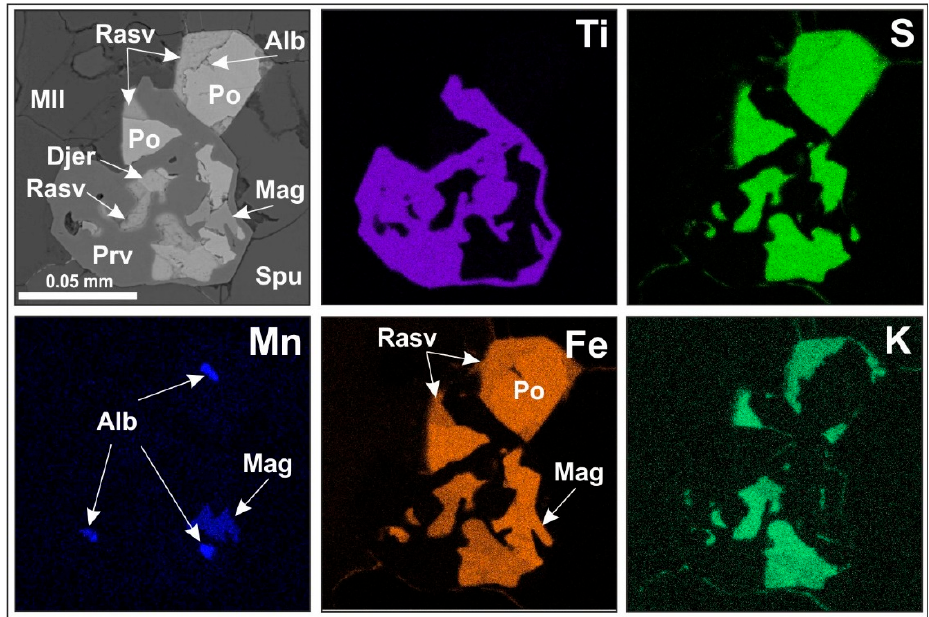
Figure 11. BSE image and X-ray elemental maps (Ti, S, Mn, Fe, K) of pyrrhotite pseudo-inclusions partially replaced by rasvumite and djerfisherite. Elemental maps (S, Fe, K) show the presence of tiny fractures, which connect such sulfide grains with the host perovskite. Kochumdek marble, Zone 2, sample PT-99. Alb = alabandite, Djer = djerfisherite, Mag = magnetite, Mll = melilite, Po = pyrrhotite, Prv = perovskite, Rasv = rasvumite, Spu = spurrite.